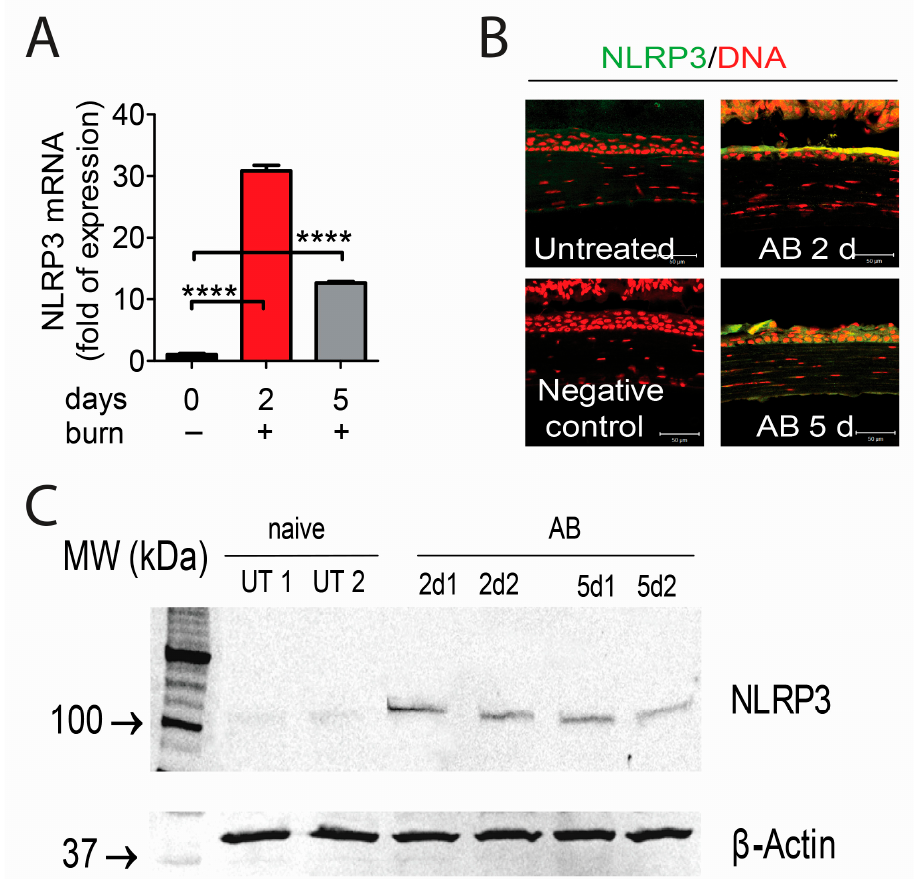
Figure 1. Upregulation of nucleotide-binding oligomerization domain-containing protein (NOD)-like receptor family pyrin domain containing 3 (NLRP3) expression by corneal epithelium in animals subjected to alkali burn (AB) at 2 days (2 d) and 5 days (5 d) post-injury. ( A ) Gene expression analysis of NLRP3 messenger mRNA (mRNA) transcript in whole cornea of animals subjected to alkali burn ( n = 8 animals/group). Graphs show means ± standard error of the mean (SEM). **** p < 0.0001; ( B ) Representative merged digital images of laser scanning confocal microscopy of corneas cryosections immunostained for NLRP3 (green) with propidium iodide nuclei counterstaining (DNA in red) in corneas subjected to alkali burn (images are representative of n = 6 animals/group). Scale bar: 50 µm; ( C ) Representative digital images of western blot of NLRP3 and β -actin in cornea epithelium of animals subjected to alkali burn for 2 and 5 days. Each lane is a different sample ( n = 12 animals/3 samples/group). MW: Molecular weight; UT: untreated control; 2 d and 5 d refer to mice subjected to alkali burn and euthanized 2 or 5 days post-injury, respectively (1 and 2 indicate different samples).